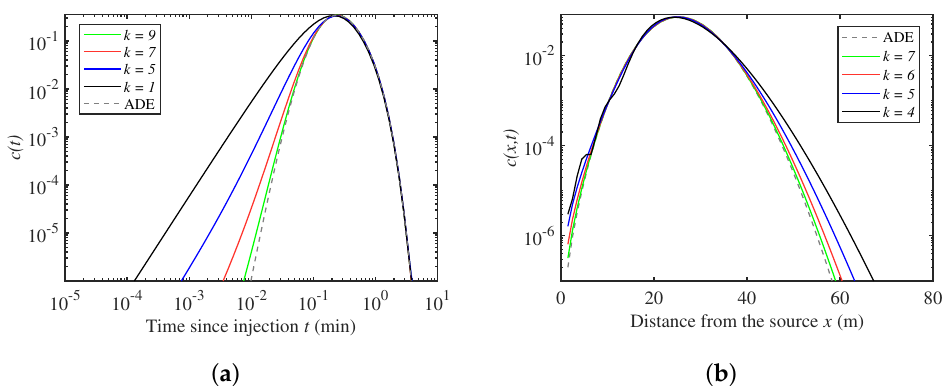
Figure 4. The simulation results of the one-dimensional PDDO-based model (9) with different parameter k . The weight functions are set as Equation (24). ( a ) The breakthrough curves with parameters R = 1, v = 0.3 m/min, D = 0.3 m 2 /min, H x = 0.6 Ω , ( b ) R = 1, v = 0.3 m/min, D = 0.2 m 2 /min, H x = 0.12 Ω , and Ω is the entire computing domain. The results of the advection– diffusion equation model (1) are also drawn for